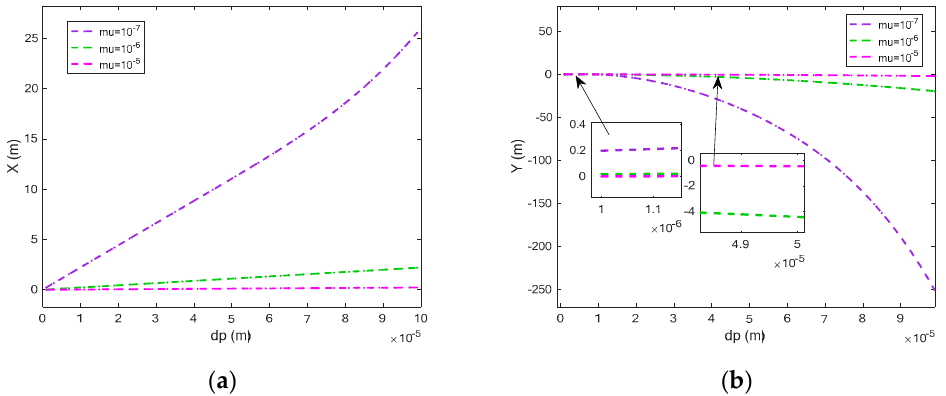
Figure 9. Particle diameter and displacement response for the same drag coefficient: ( a ) X -axis displacement response; ( b ) Y -axis displacement response.